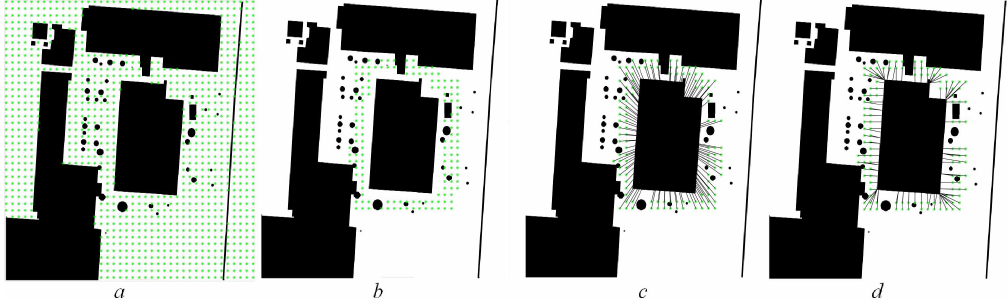
Figure 20. The initial sample viewpoints ( a ), the sample viewpoints located at the optimal range from the building ( b ), and the direction of each viewpoint for centre pointing ( c ) and façade pointing ( d ).